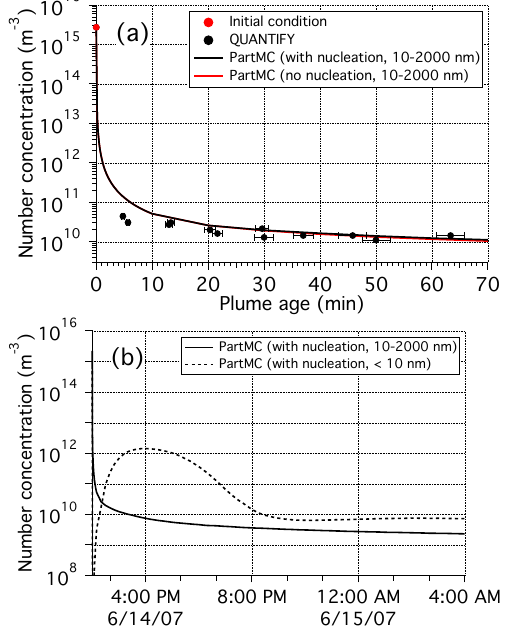
Fig. A2. Measured aerosol number distributions for background, Figure A2. Measured aerosol number distributions for background, initial and ship corridor and modeled results with nucleation for initial and ship corridor and modeled results with nucleation for (a) base case (from 2 pm) (b) sensitivity case (from 06:00 TS8 ) at (a) base case (from 14:00LT) (b) sensitivity case (from 06:00LT) at plume ages of 100, 1200s, 1, 5 and 14h. The error bars represent plume ages of 100s, 1200s, 1h, 5h and 14h. The error bars repre- 95% confidence intervals from 5 ensemble runs (only shown for sent 95% confidence intervals from five ensemble runs (only shown size distribution at 100s as an example). for size distribution at 100s as an